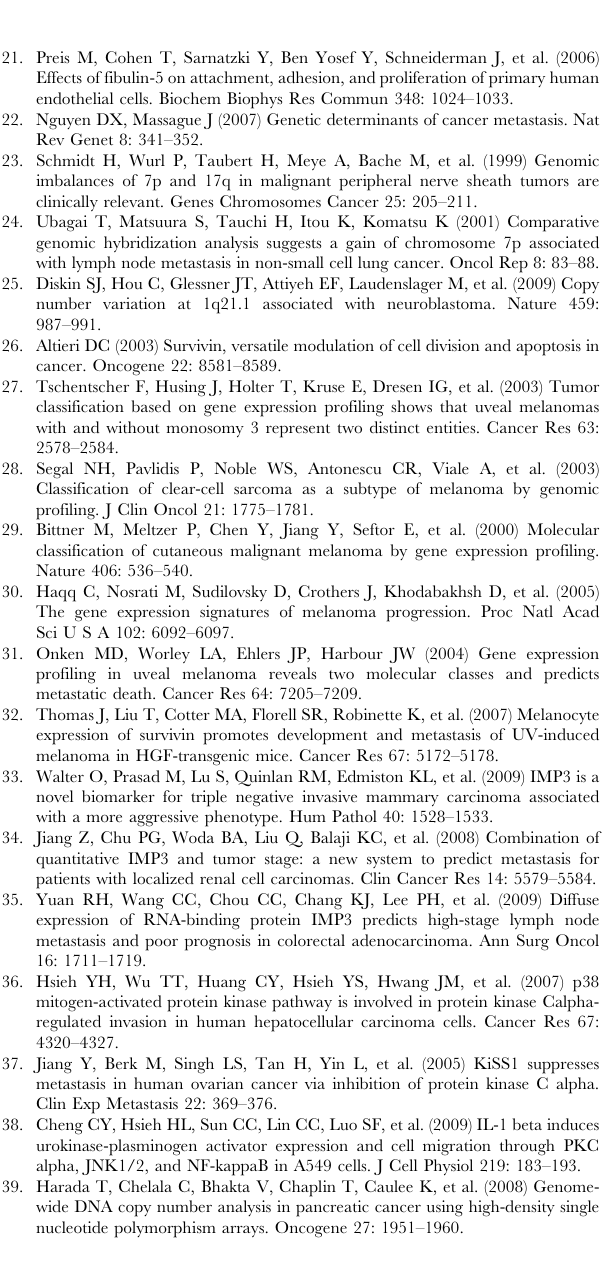
Figure S5 Quantitative PCR assessment of levels of mRNA knockdown of ASPM, AKAP9, IMP3, PRKCA, RPA3 and SKAP2 in 1205LU cells following transfection of siRNA oligo pools. % mRNA knockdown is relative to transcript levels after transfection of a non-targeting siRNA pool (see methods). Ranges in knockdown levels reflect standard deviations from three replicates. Table S1 Sample annotation and clinical Information on melanoma samples from Medical University of Vienna, Austria.